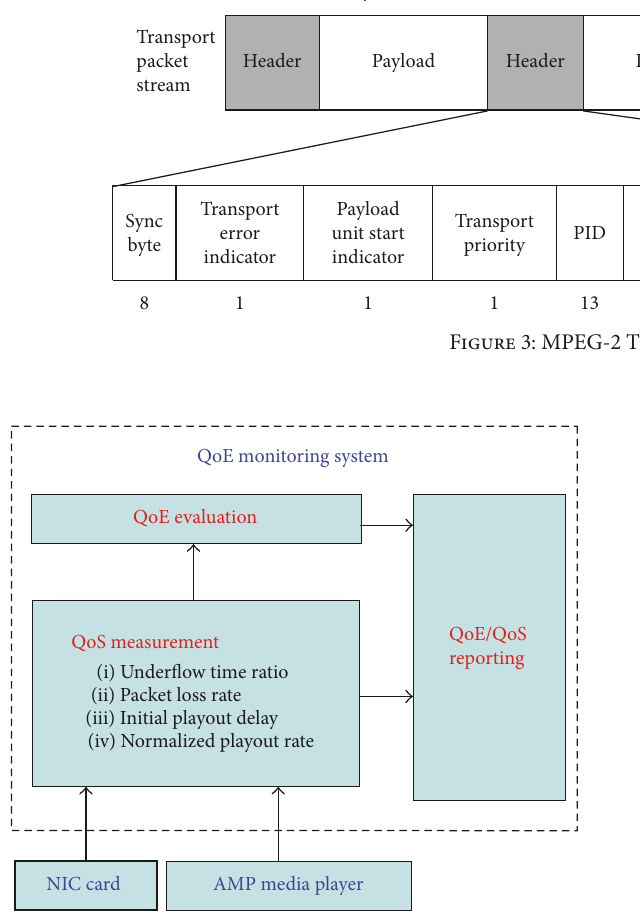
Figure 4: Architecture of the QoE monitoring system.